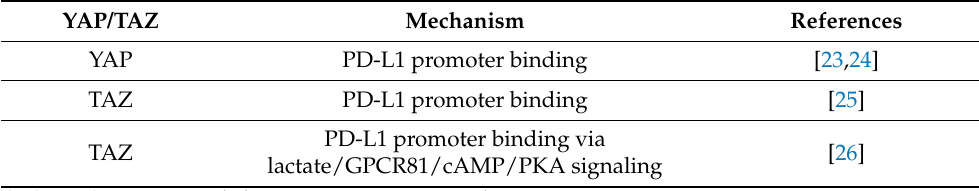
Table 1. Transcriptional regulation of PD-L1 by YAP and TAZ in NSCLC.